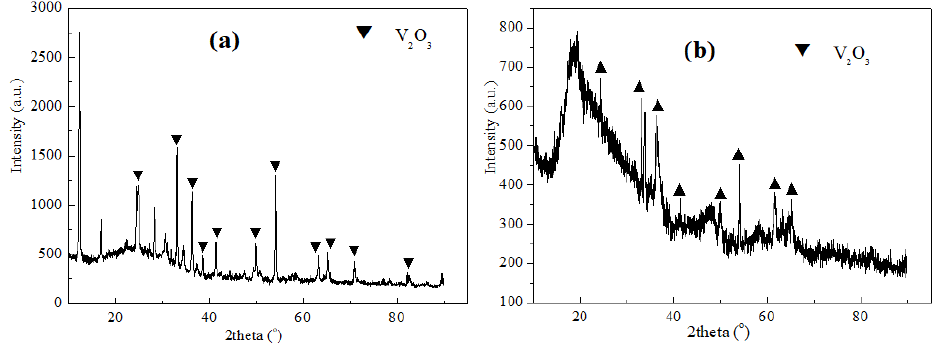
Figure 6. Phase analysis results of KVO 3 and NaVO 3 reduction products. ( a ) KVO 3 ; ( b ) NaVO 3